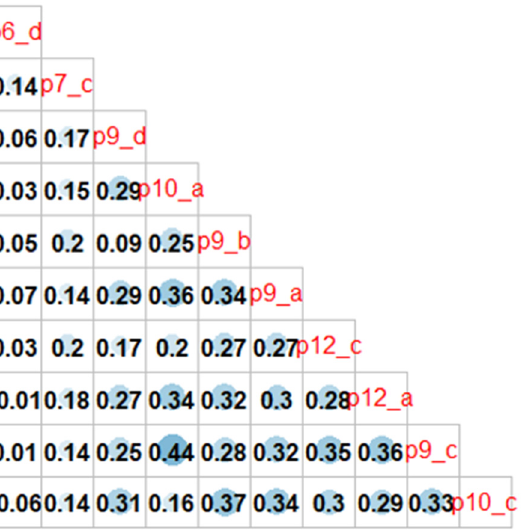
Figure 6. Correlation between the didactics of the social sciences and the formation oriented to geographical and historical thought.